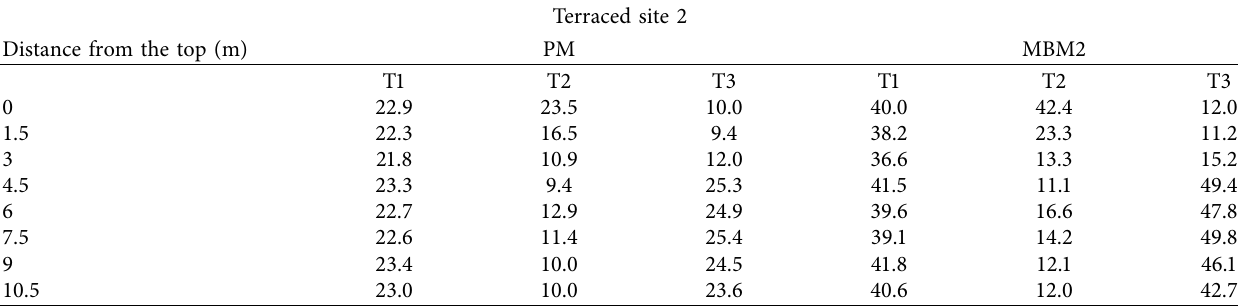
Table 2: Soil erosion rates t/ha/yr associated with site 2 for different points of the transects using the Proportional Model (PM) and Mass Balance Model 2